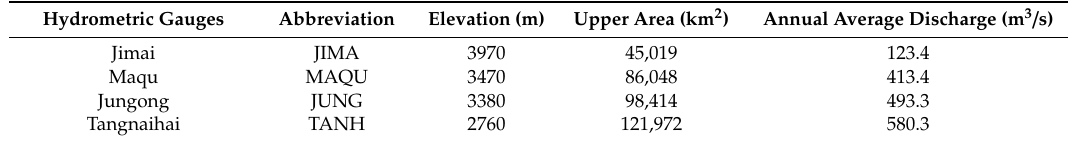
Figure 1. Topographical features, river networks, and hydrometeorological gauges in the Upper Yellow River Basin (UYRB). Table 1. Hydrometric gauges in the UYRB.